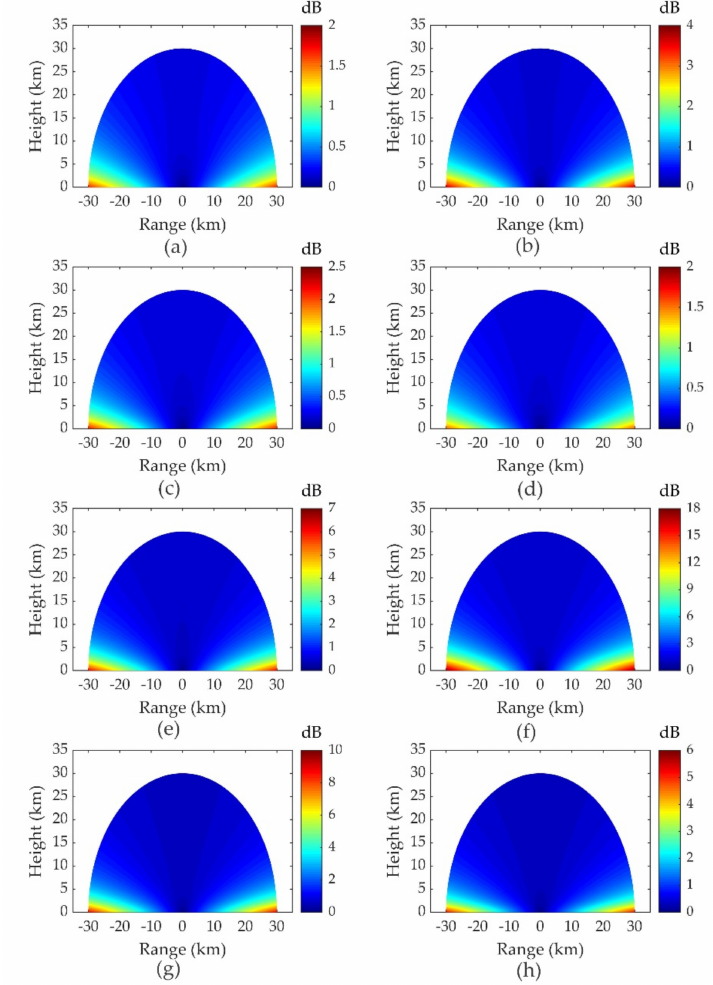
Figure 3. Two-way gaseous attenuation at 35 GHz and 94 GHz at Yangbajing: ( a ) 35 GHz in spring; ( b ) 35 GHz in summer; ( c ) 35 GHz in autumn; ( d ) 35 GHz in winter; ( e ) 94 GHz in spring; ( f ) 94 GHz in summer; ( g ) 94 GHz in autumn; ( h ) 94 GHz in